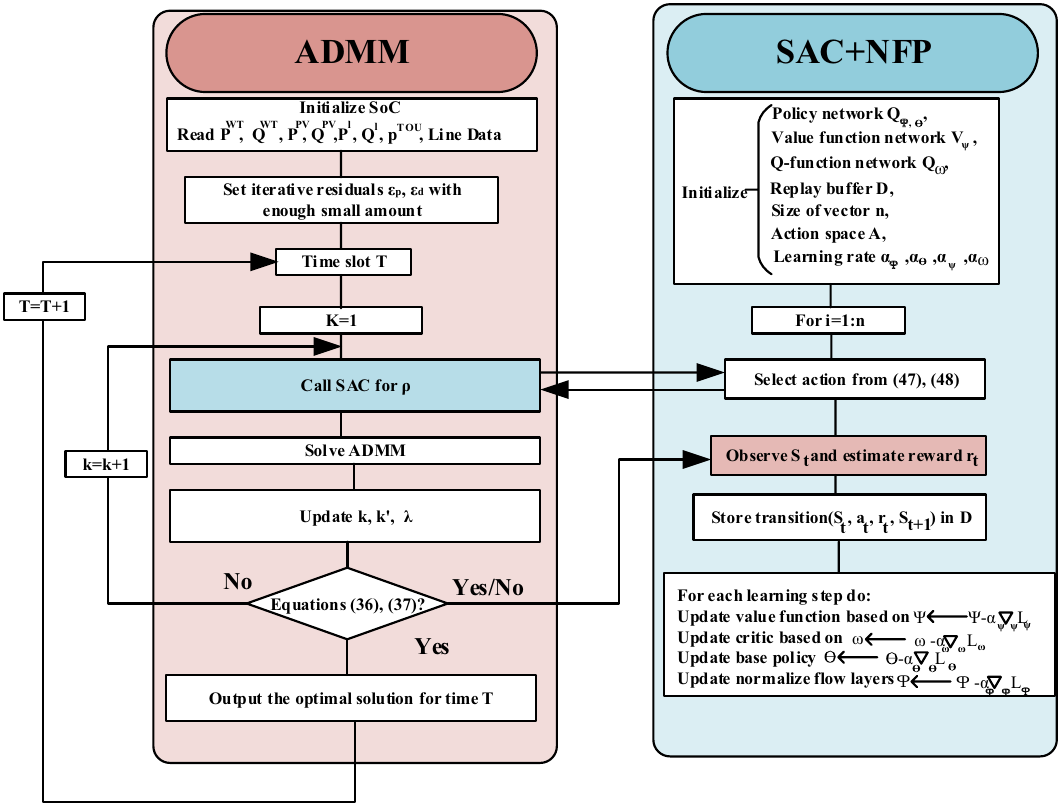
Figure 2. The proposed optimization algorithm for Gasa island EMS based on